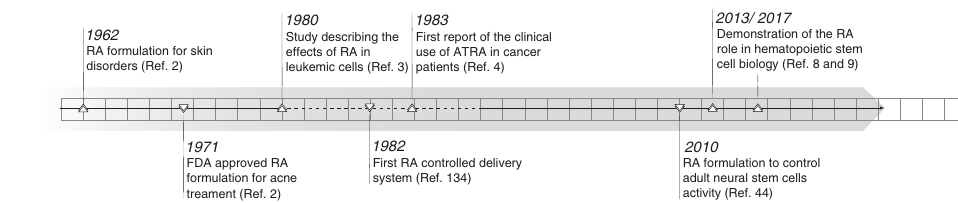
Fig. 1 Milestones in RA formulations research. ATRA all- trans retinoic acid, FDA Food and Drug Administration, RA retinoic acid.